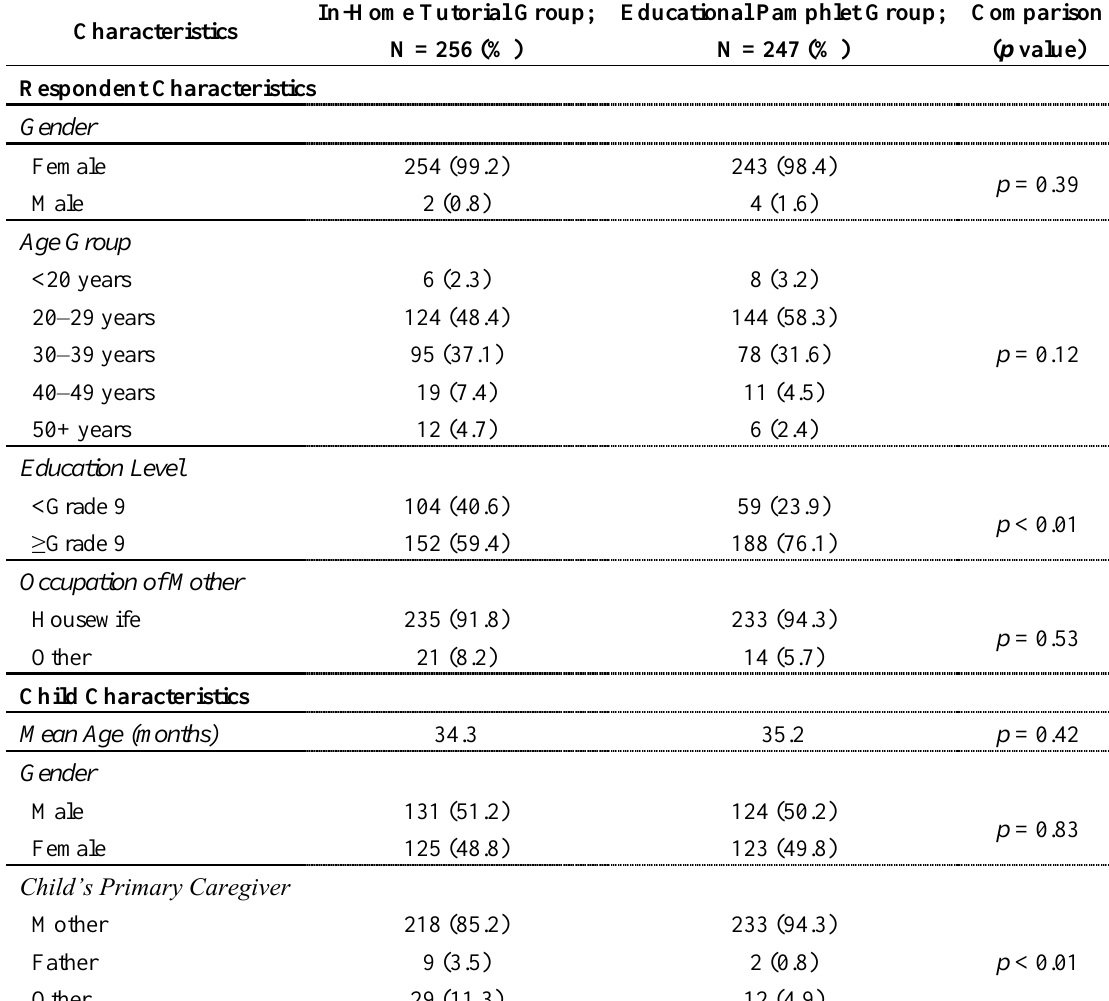
Table 1. Demographic characteristics of enrollees by